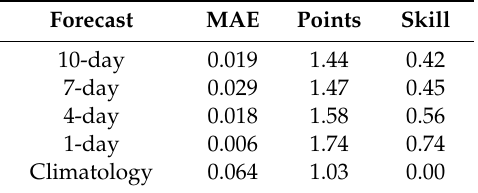
Table 3. As in Table 2, except for the mean absolute error (forecast − observations = MAE), mean number of points for the forecast period (0.00–2.00), and skill score